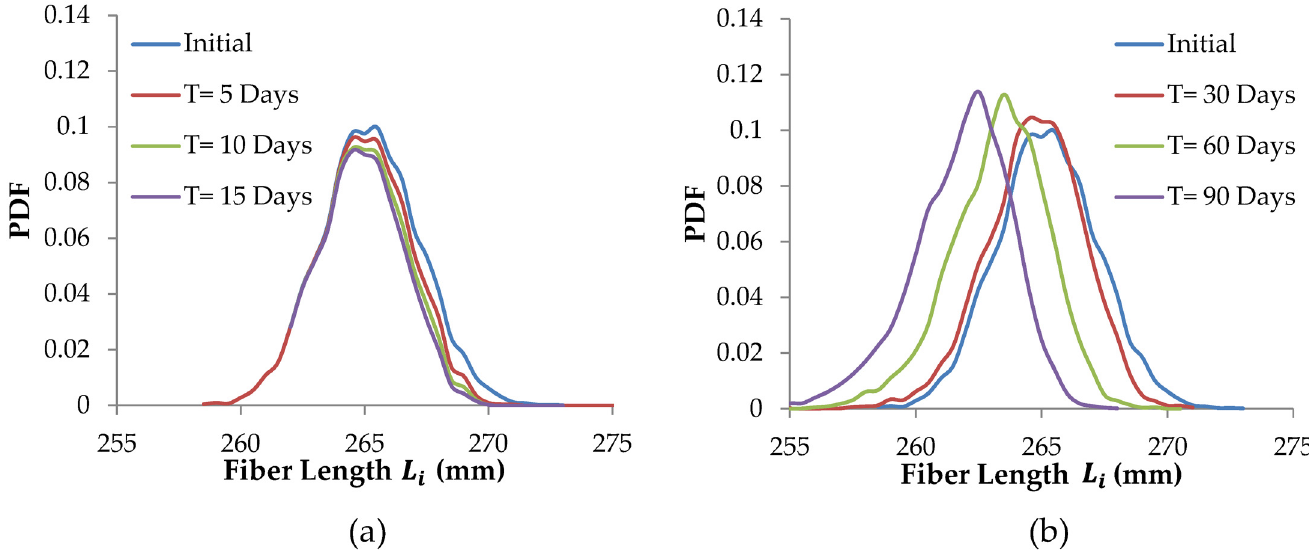
Fig 9. Tendon remodeling by proteolytic damage and repair. (a) tendon remodeling by proteolytic damage alone over 15 days, b) tendon remodeling by proteolytic damage and repair over 90 days. Tendon peak force and number of loading cycles are kept constant for all simulated